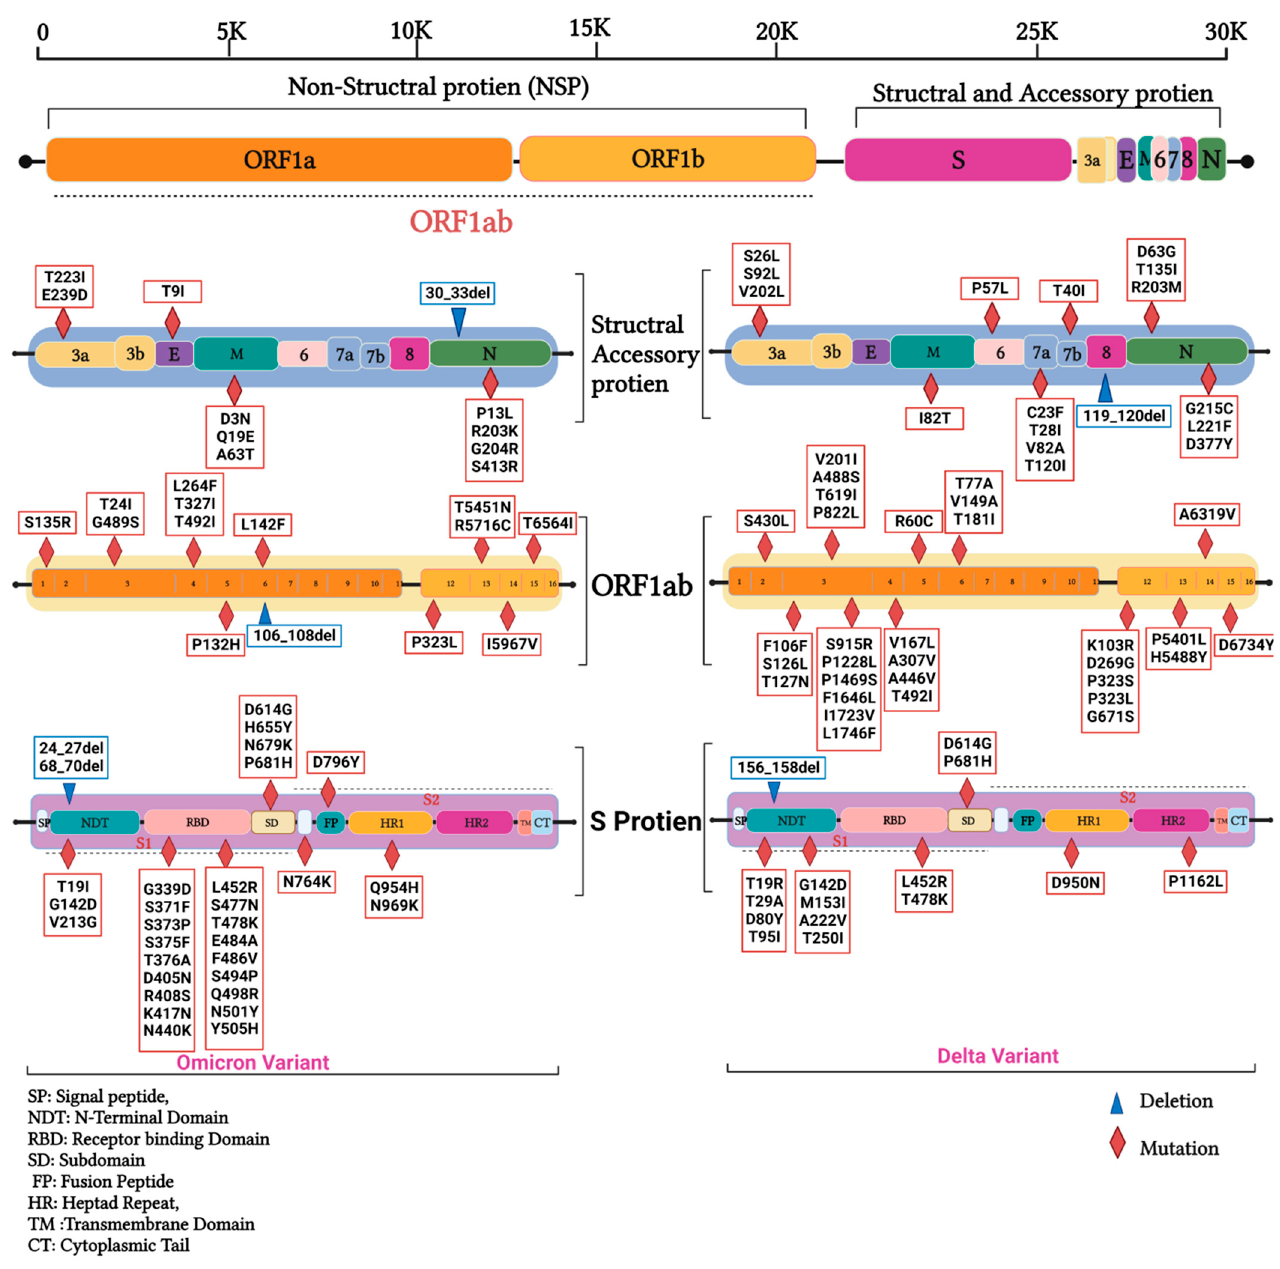
Figure 7. Distribution of amino acid variants on genomes of the Iraqi sequences from the third wave of the SARS-CoV-2 pandemic. ARS-CoV-2 genetic variations in the isolates from Duhok during the third and fifth waves of the pandemic compared to reference sequence NC_045512.2.